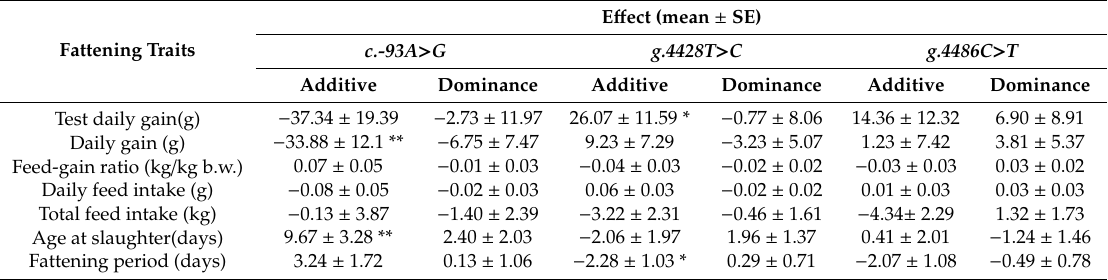
b.w: body weight, * the means in rows di ff er significantly, p ≤ 0.05; ** the means in rows di ff er significantly, p ≤